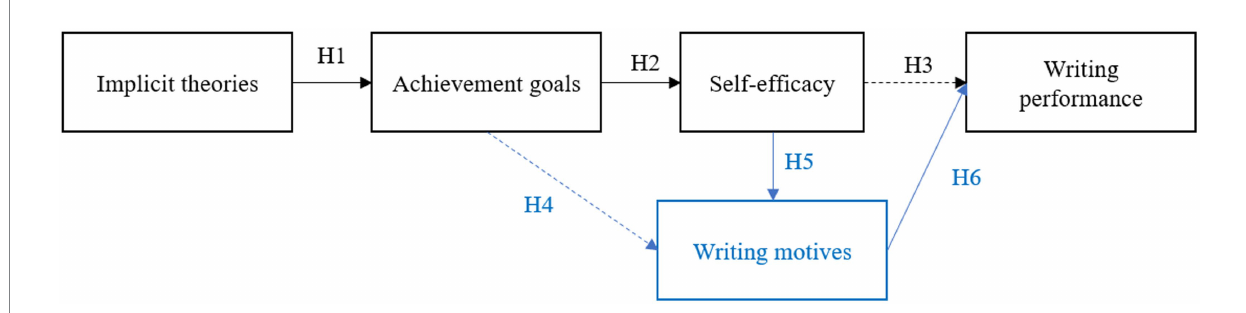
FIGURE 1 Hypothesized relational model. H1 , H2 , and H3 were studied in Limpo and Alves (2017). The current study expands this by additionally including H4 , H5 , and H6 in the relational model (in